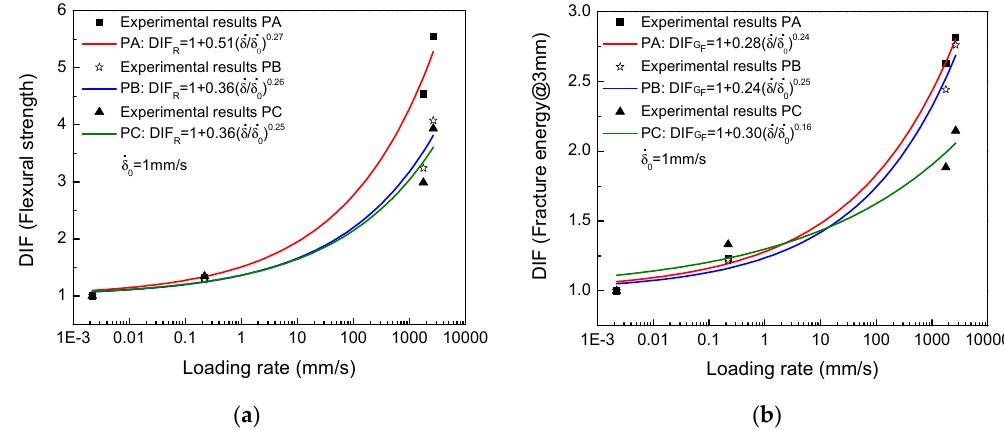
Figure 9. ( a ) Loading rate effect on the flexural strength ( b ) Loading rate effect on the fracture